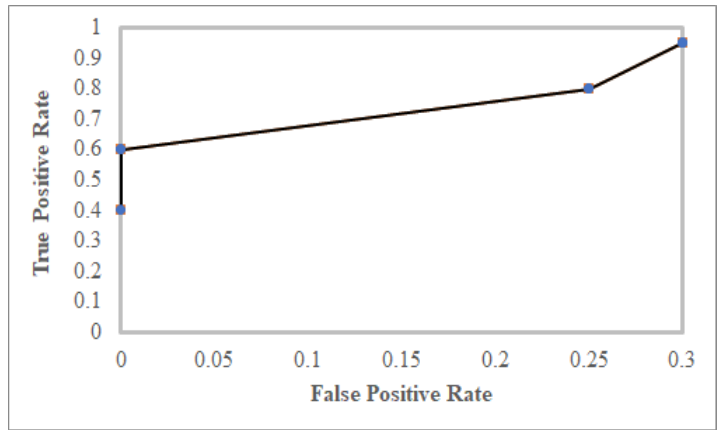
Figure 15. The ROC curve of FraudMove.